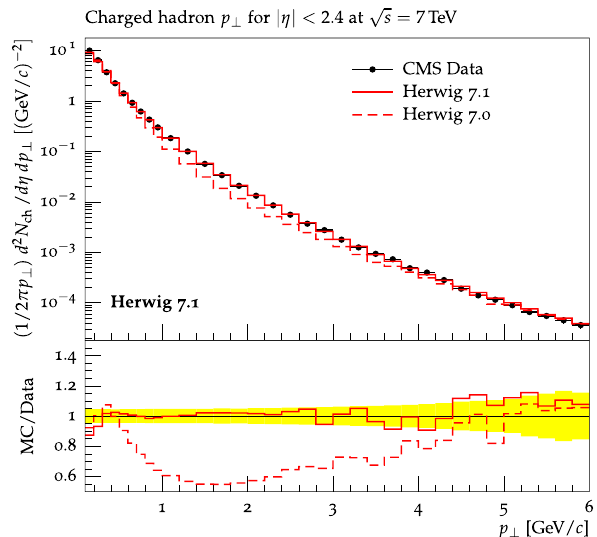
Fig. 8 Low transverse momentum spectrum of charged particles in non-single diffractive events with our old and new models for soft inter- actions compared to CMS data [40]